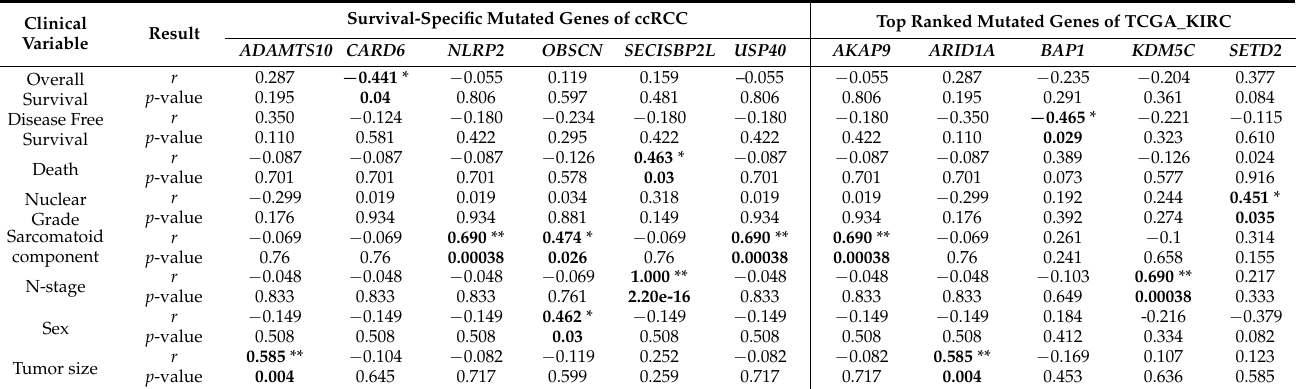
Table 4. Eleven clinicopathologically significant mutated genes found in 22 Korean patients with clear cell renal cell